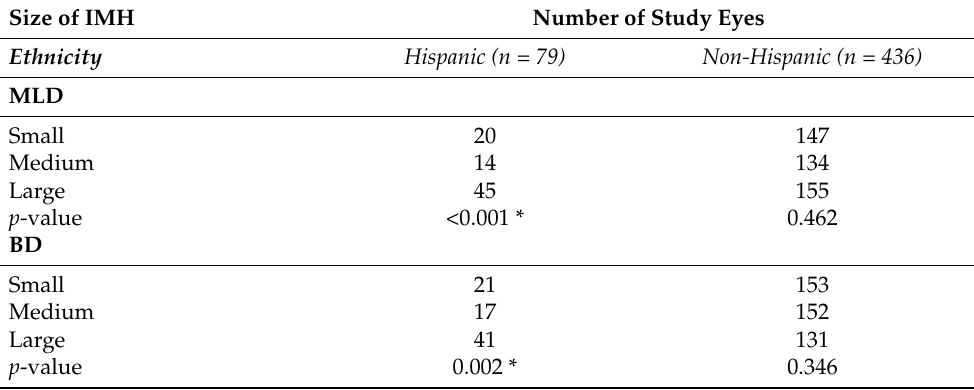
Table 5. Number of small, medium, and large IMH by MLD and BD categorized by ethnicity. Size of IMH